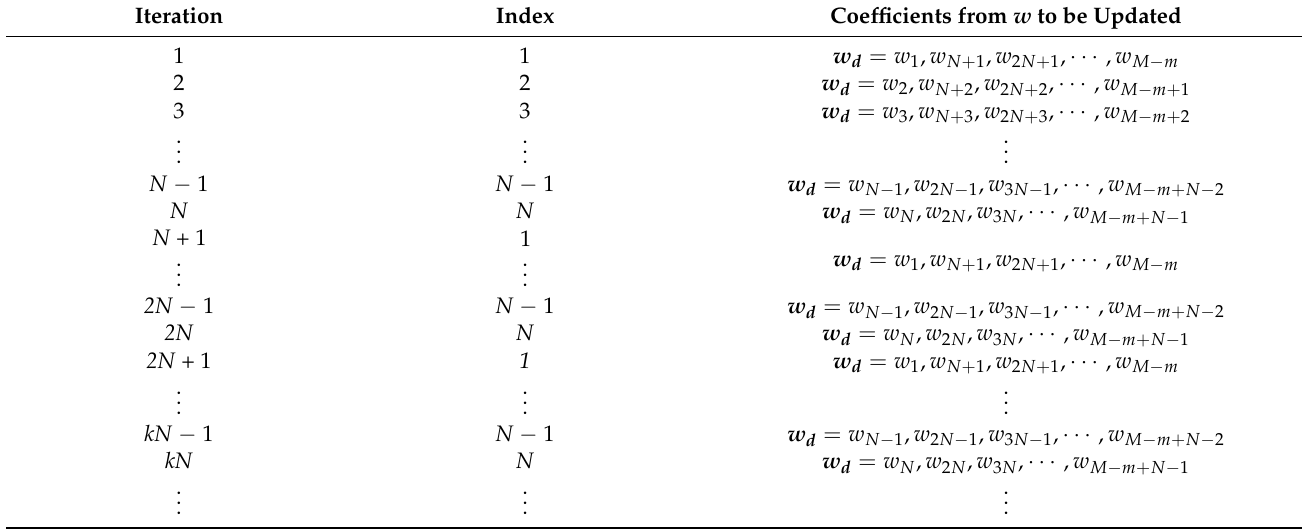
Table 1. Logical M/N -length subfilter updated at every